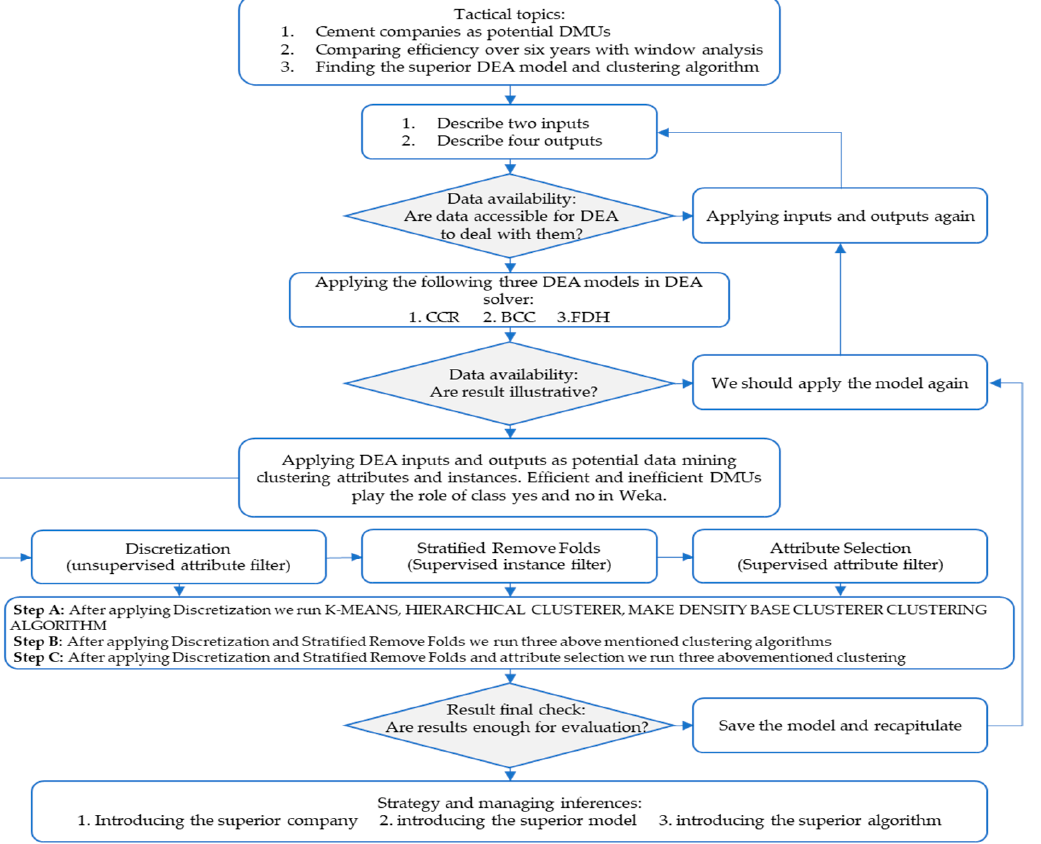
Figure 5. Assessment procedure of the combination of DEA with clustering.